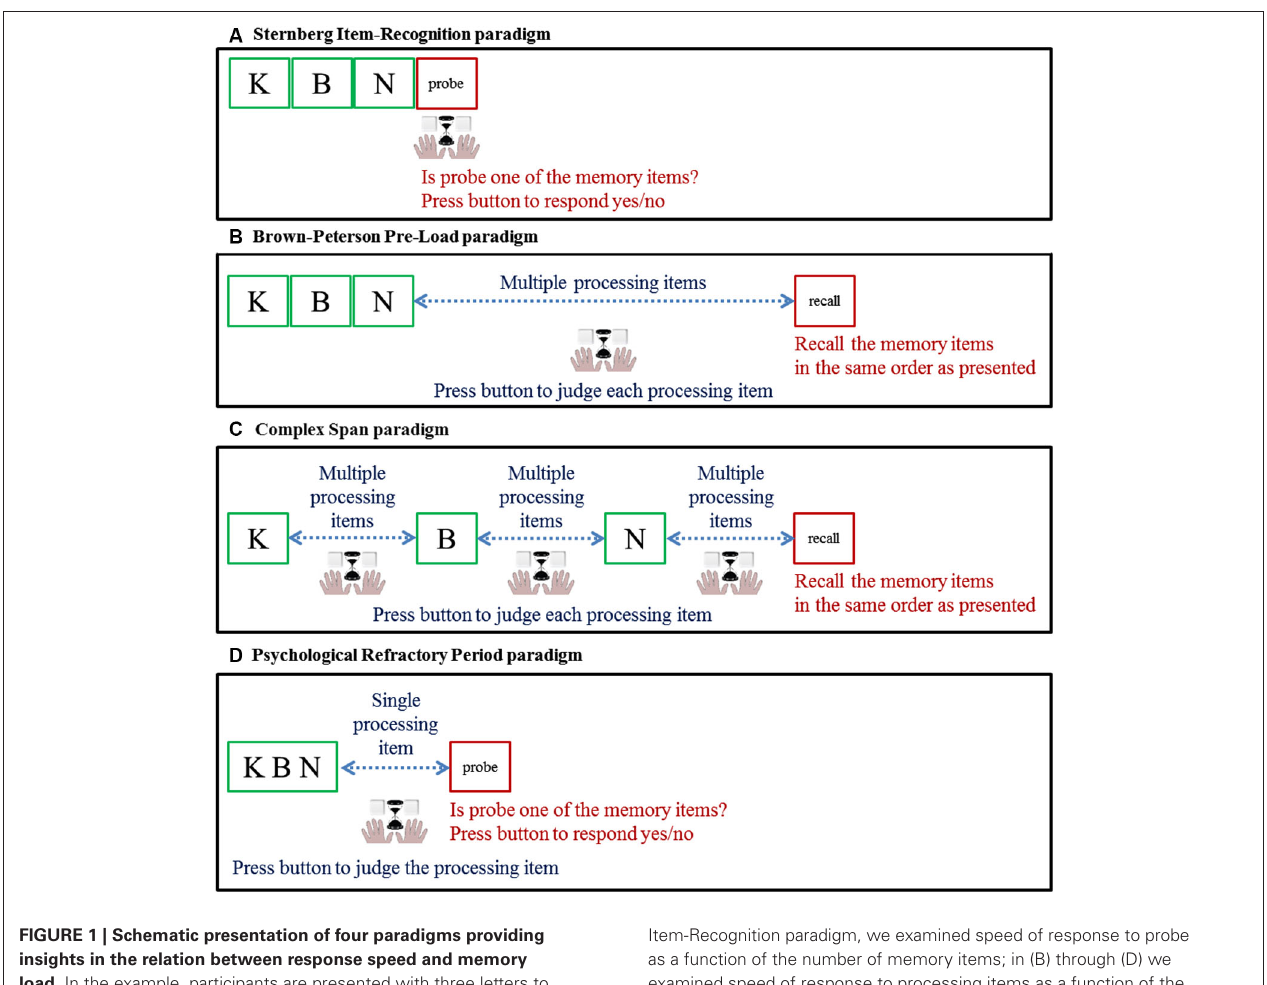
FIGURE 1 | Schematic presentation of four paradigms providing insights in the relation between response speed and memory load. In the example, participants are presented with three letters to be maintained: K, B and N. The hand symbol together with the hourglass refers to a response given by pressing a button for which the speed is the variable of interest here. In (A) the Sternberg